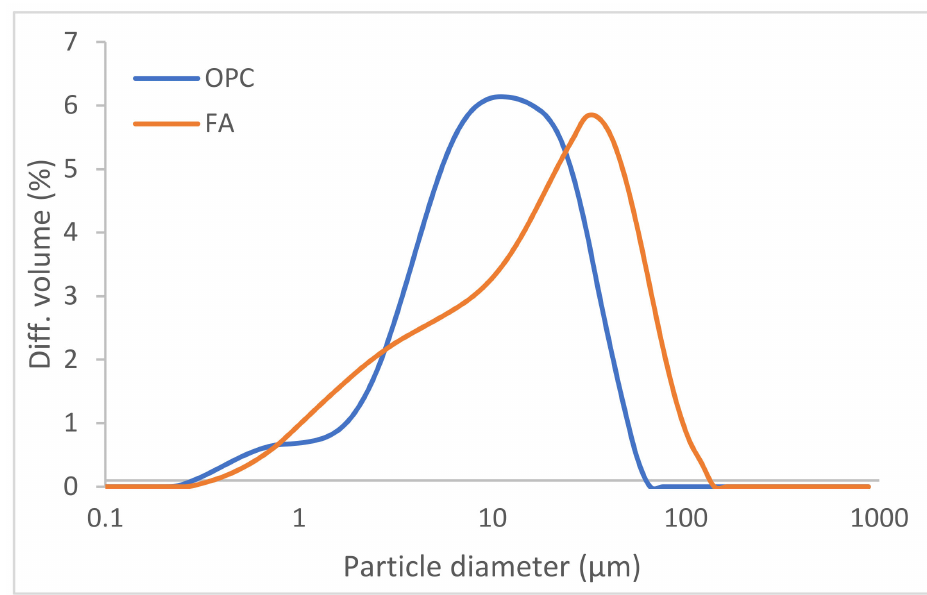
Figure 1. OPC and FA particle size